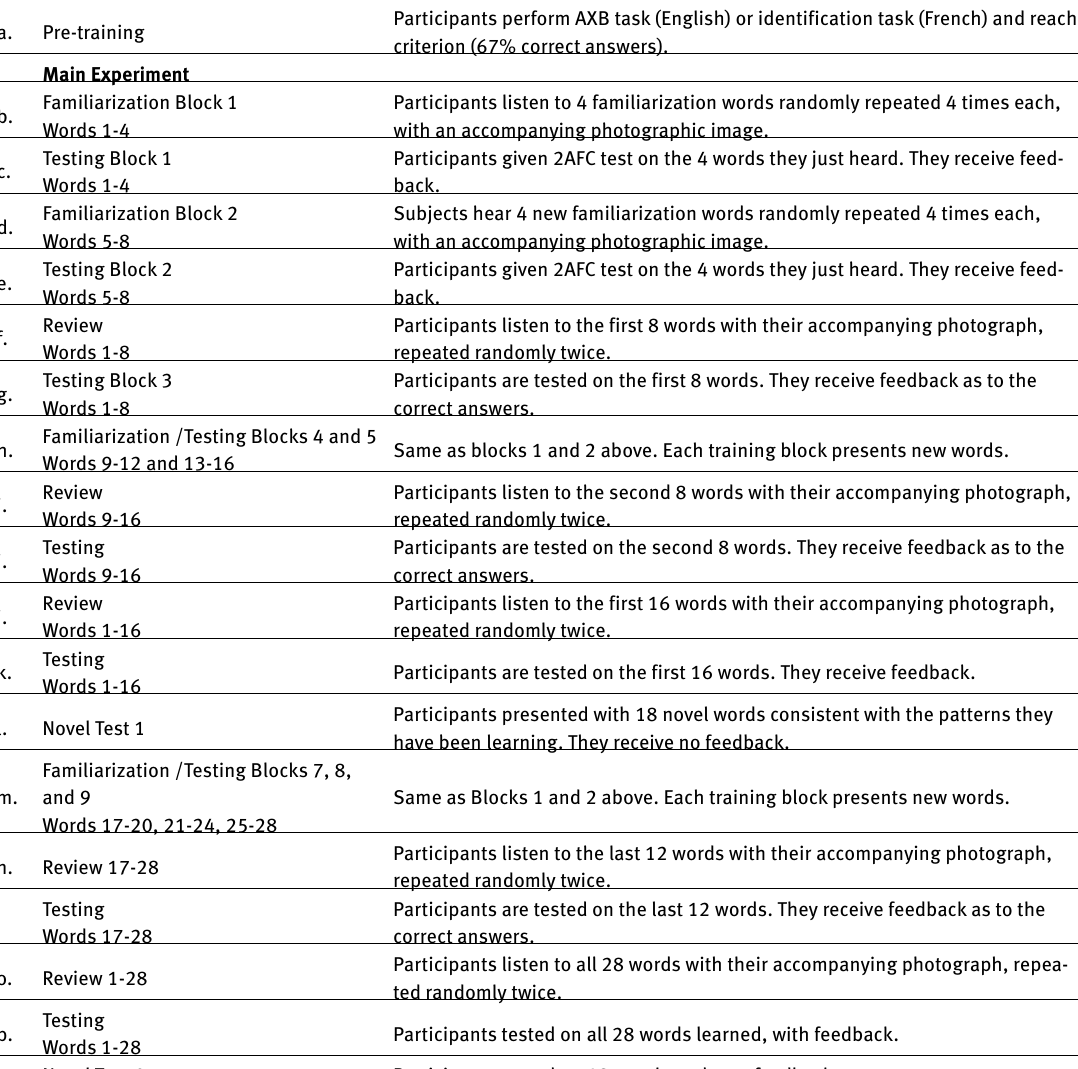
Table 4 Familiarization and Testing